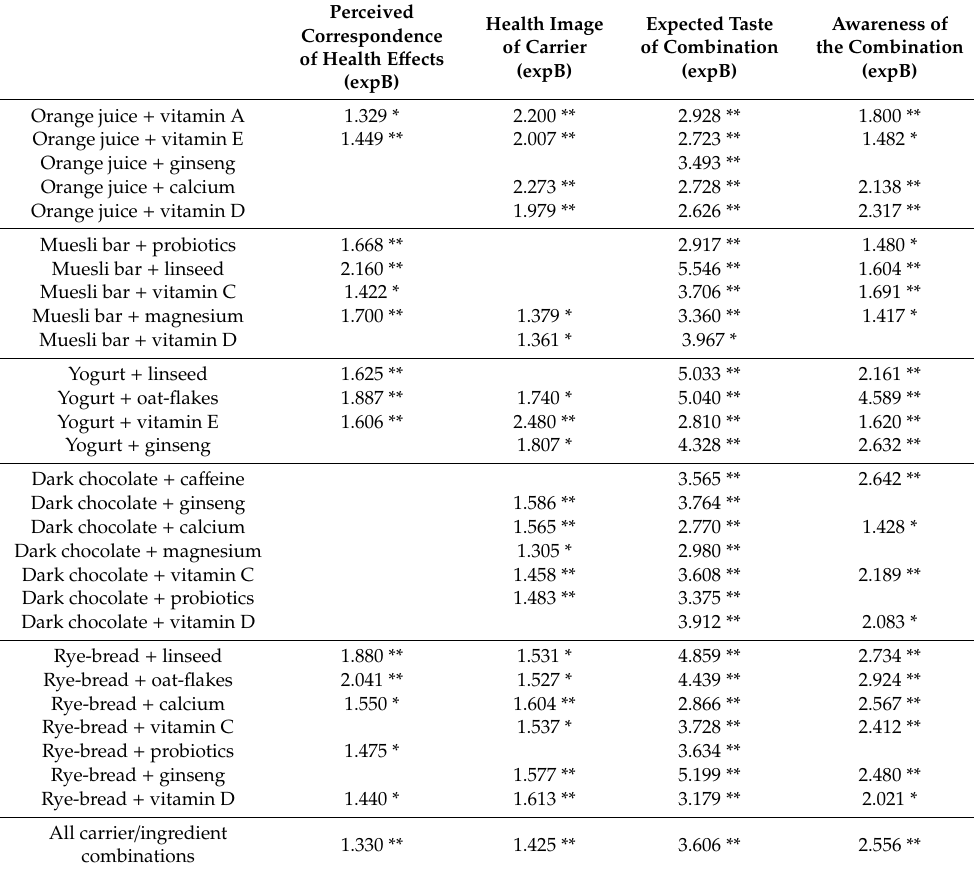
Table 3. The role of the influencing factors in the fit perception of 28 functional food carrier / ingredient combinations ( n = 1016, 28 answers per